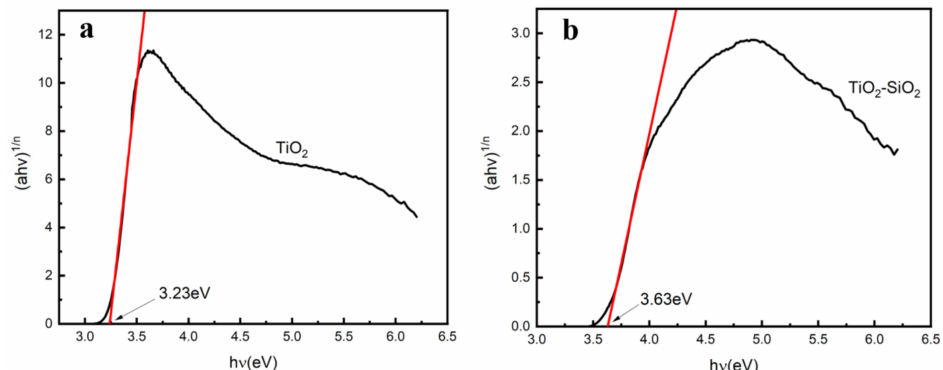
Figure 11. Estimated band gaps of ( a ) TiO 2 prepared from P. pastoris GS115 as a template and ( b ) TiO 2 -SiO 2 prepared from P. pastoris GS115 as a template based on the Tauc/Davis–Mott model.